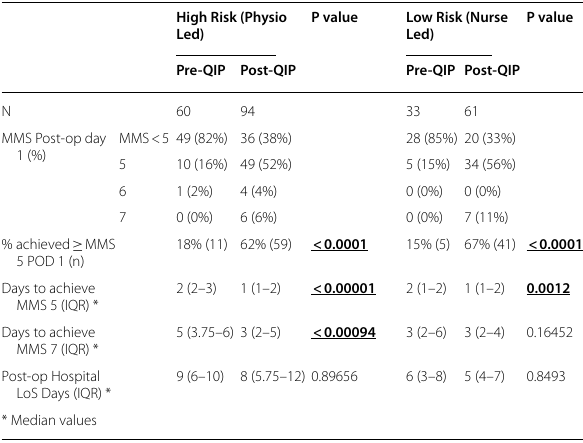
Table 1 MMS Post-op day 1 pre and post physiotherapy led teaching